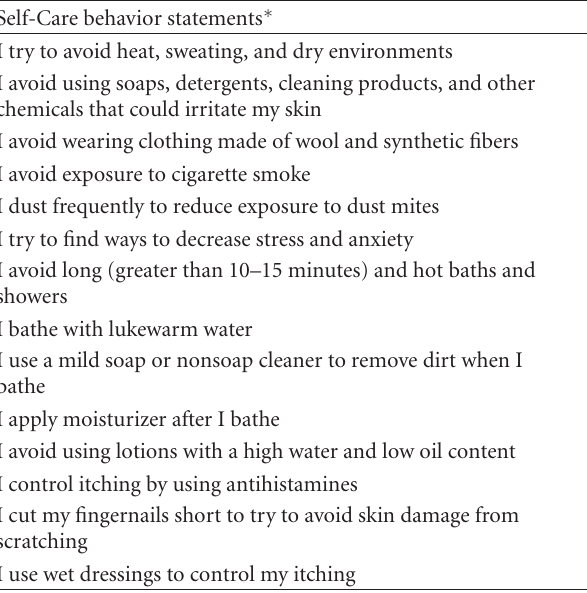
Table 3: List of self-care behavior statements in survey. Self-Care behavior statements